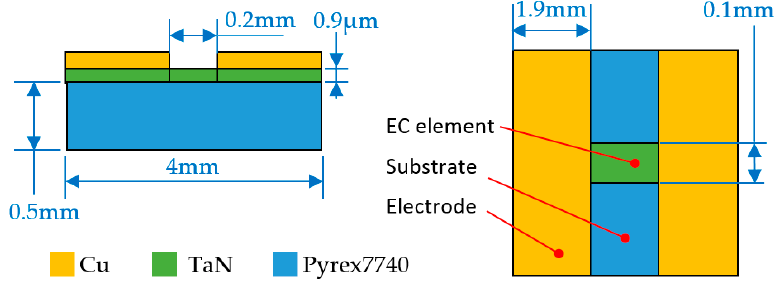
Figure 5. Three dimensions and material of EC element under ignition analysis.